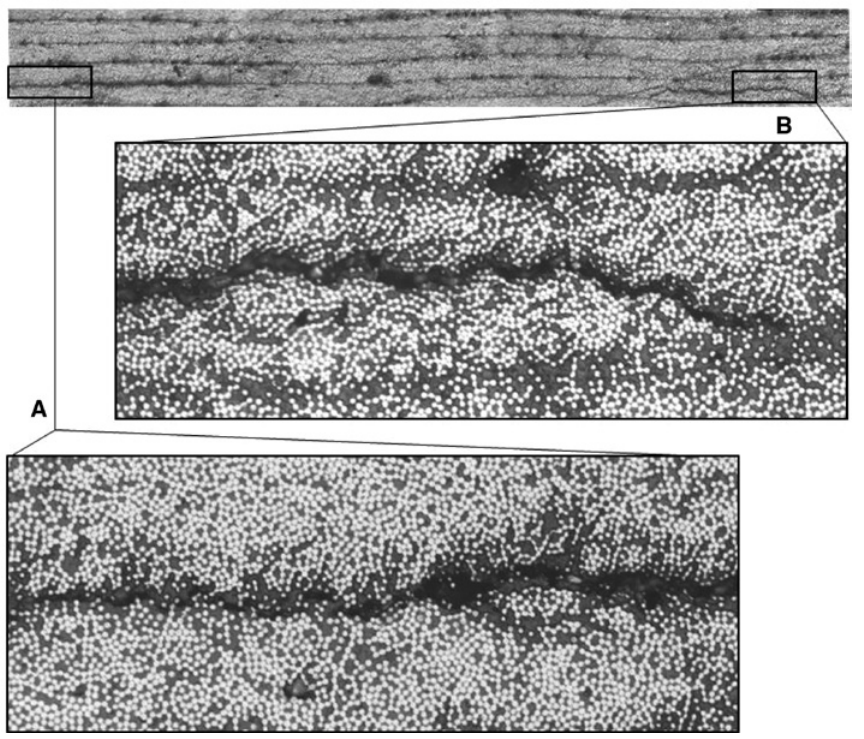
Figure 1: Two optical microscopy images of the UD laminate. Adjacent voids were connected to form horizontal defects (with microcracks) between two plies (A, inset) and also to delaminate the composite within a single ply (B,